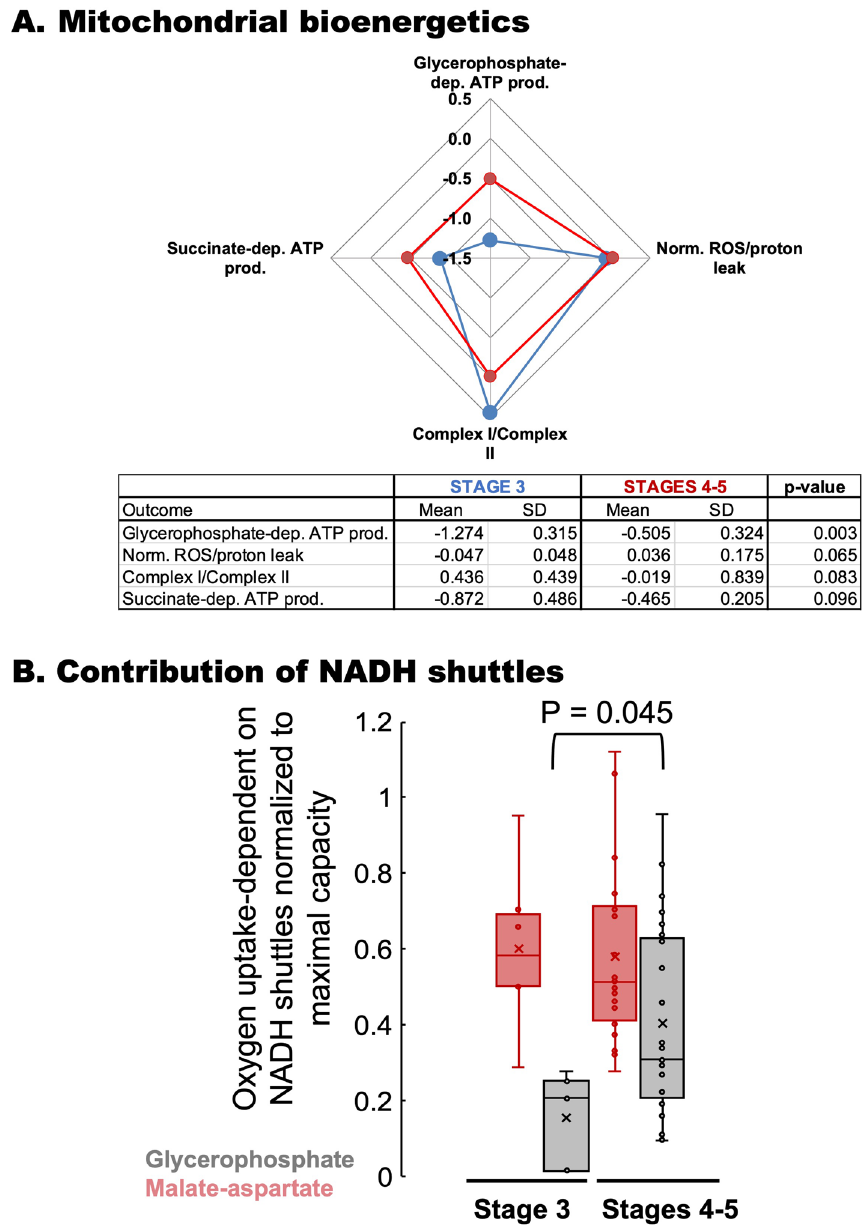
Figure 5. Bioenergetics of PBMCs from patients at Stages 3 vs. 4–5. ( A ) Mitochondrial bioenergetic outcomes from PBMCs obtained from carriers and assigned by the VRE algorithm at Stage 3 (Fig. 2C, box C) and Stages 4–5 (Fig. 2C, box D) were plotted using a spiderweb chart. For simplicity, only those with p ≤ 0.1 were shown. Bottom panel: Statistical analyses performed by using an unpaired two-tailed Student’s t test with unequal variances. dep. Dependent, prod. Production, Norm. normalized to glucose–glutamine respiration. ( B ) Contribution of NADH shuttles: The oxygen-linked ATP production fueled by glucose–glutamine of primary fibroblasts from carriers (Malate-aspartate in red) was taken as a surrogate for the contribution of the malate- aspartate shuttle. The oxygen-linked ATP production fueled by glycerol-3-phosphate (GP in grey) was taken as the contribution of the glycerophosphate shuttle. Both rates were normalized to the maximum respiratory rate 120 . A two-tailed Student t test for unpaired data with unequal variance was run for GP with no statistical difference [ t (29) = 0.203; p = 0.840] but with statistical significance for Malate-Aspartate [ t (26) = − 2.102; p = 0.045]. Data were visualized by using a box plot. Each box enclosed 50% of the data (closed or open circles) with the median value of the variable displayed as a line and the mean as an x. The top and bottom of the box mark the limits of ± 25% of the variable population. The lines extending from the top and bottom of each box mark the minimum and maximum values within the dataset that fall within an acceptable range. Any value outside this range, called an outlier, is displayed as an individual point whose value is outside the upper quartile + 1.5 × interquartile range and lower quartile − 1.5 × interquartile range. The height of each box represents the interquartile